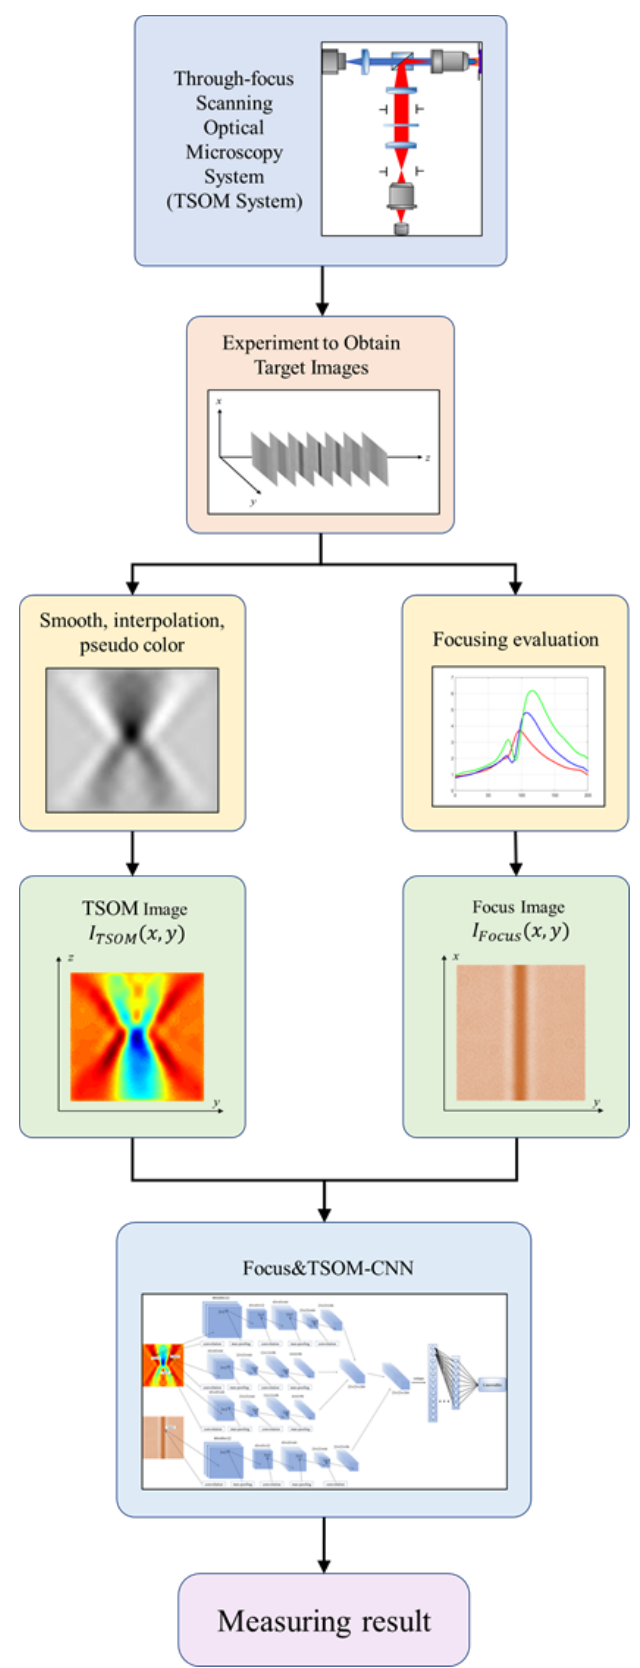
Figure 1. Measurement process of the two-input deep-learning TSOM method.